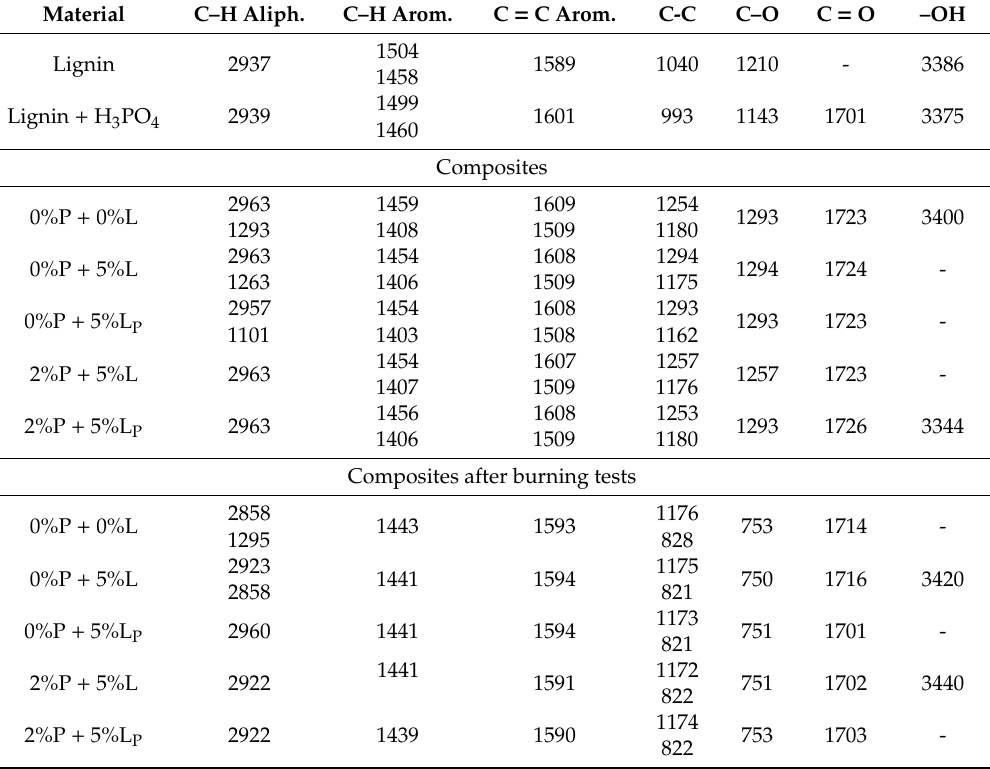
Table 1. Wavenumbers (1 / cm) of characteristic bands visible in the Fourier transform infrared —attenuated total reflectance spectra.